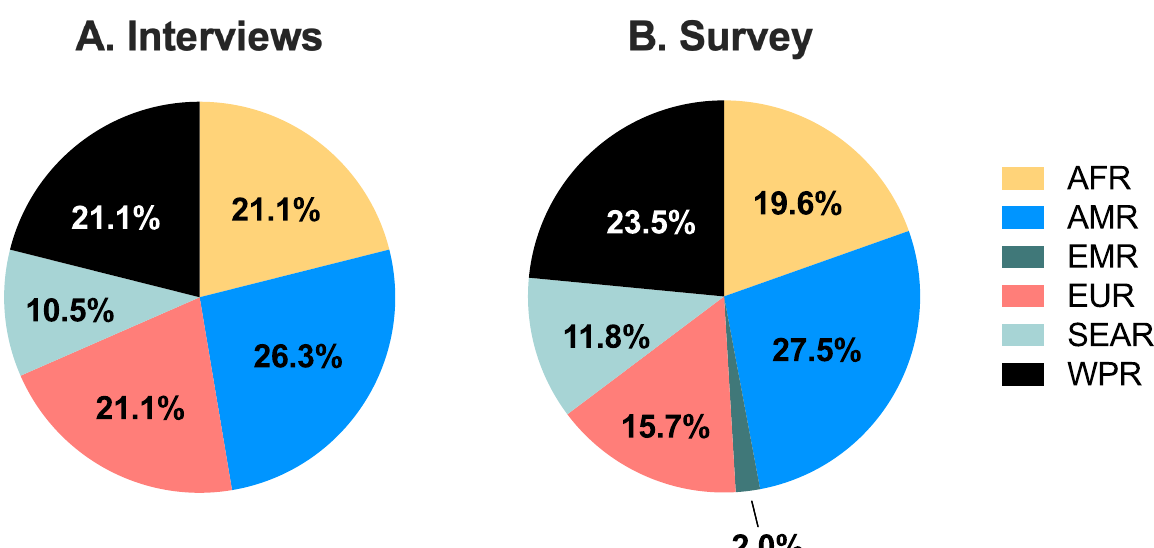
Fig 1. Stakeholders’ distribution by WHO global regions. The proportion of stakeholders who participated in the (A) interviews (n = 23) and (B) survey (n = 46), in each of the WHO global regions. AFR = African region (yellow), AMR = Region of the Americas (blue), SEAR = South-East Asian region (light green), EUR = European region (red), EMR = Eastern Mediterranean region (dark green), WPR = Western Pacific region (black).